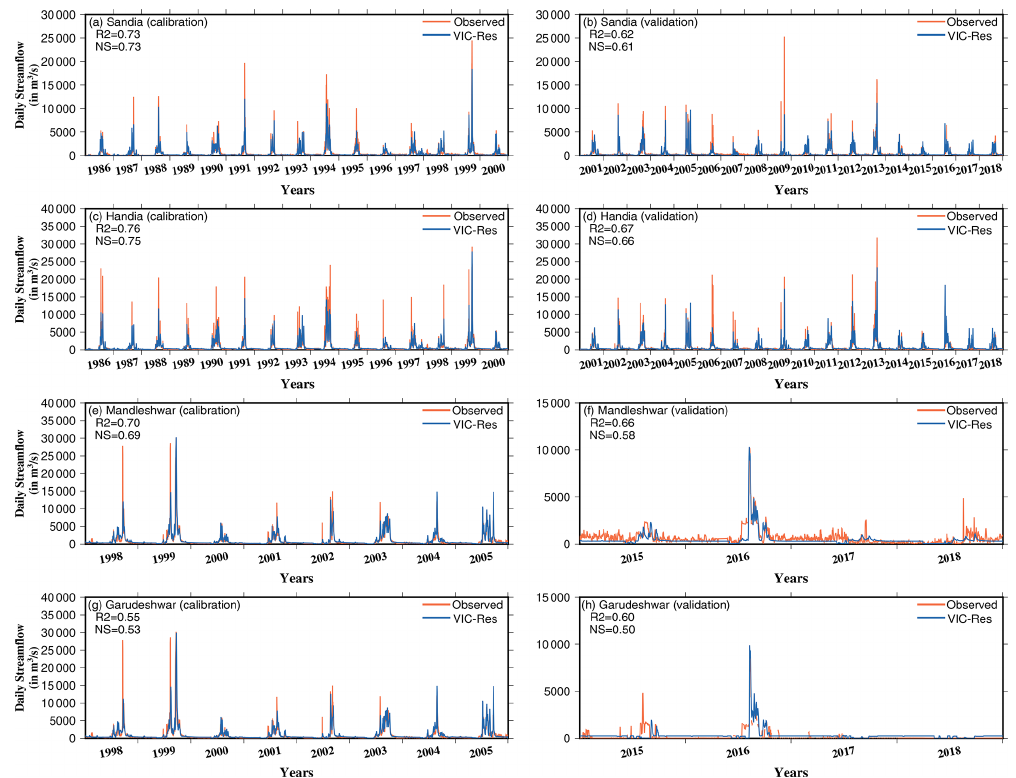
Figure 6. Calibration and evaluation of the VIC-Res model against observed daily streamflow at gauge stations at Sandia, Handia, Man- dleshwar and Garudeshwar. The performance of the VIC-Res model in simulating daily streamflow was evaluated using the R 2 and